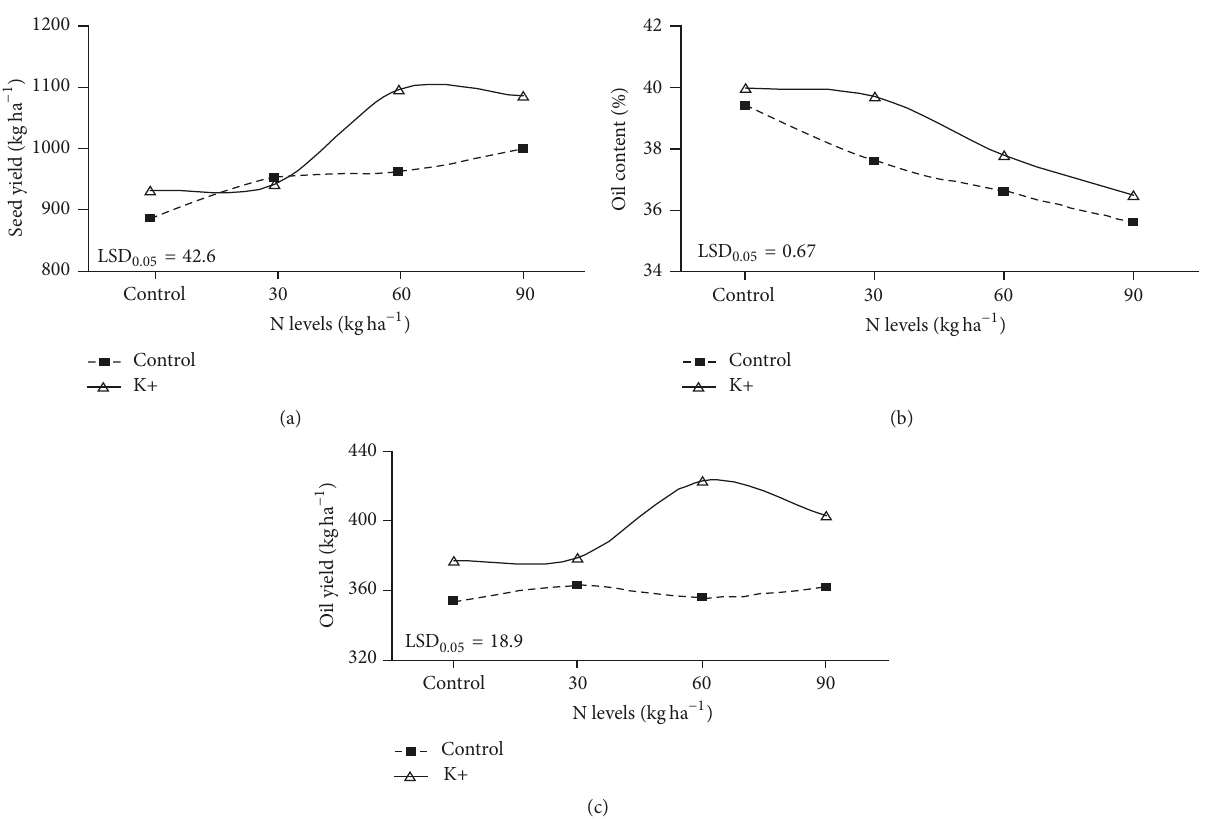
Figure 1: Changes in seed yield (a), oil content (b), and oil yield (c) of black cumin as affected by N doses and supplemental K application.